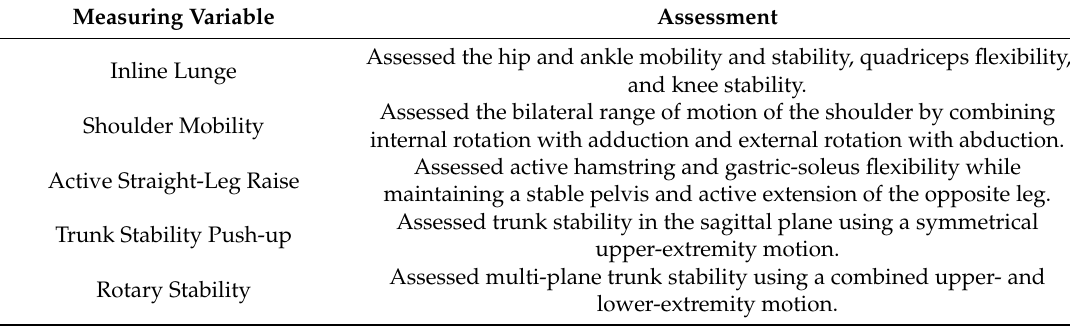
Table 2. Scores of the contents in the Functional movement screen evaluation .